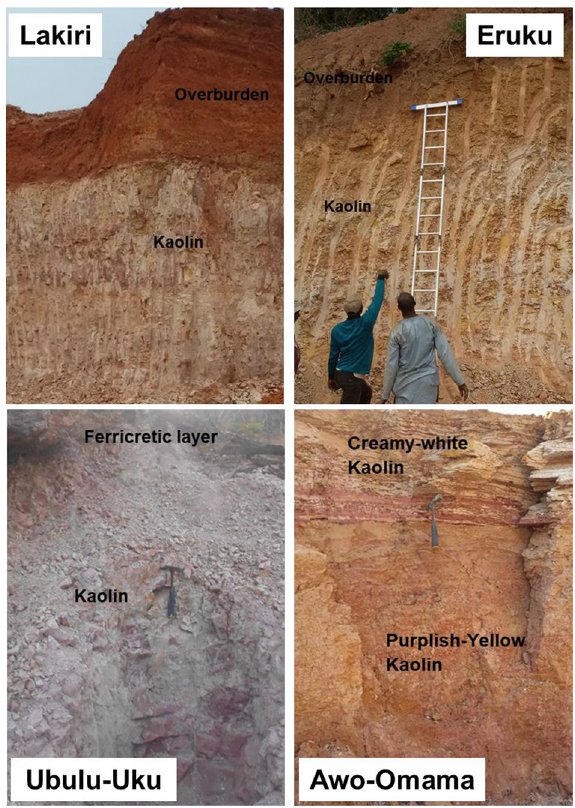
Figure 3. Profile views of the studied Cretaceous–Paleogene/Neogene kaolin deposits.